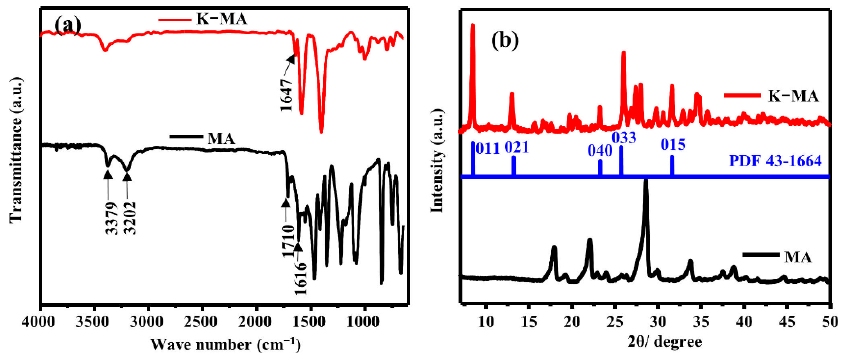
Figure 1. ( a ) FTIR spectra ( b ) XRD patterns of MA and K − MA.